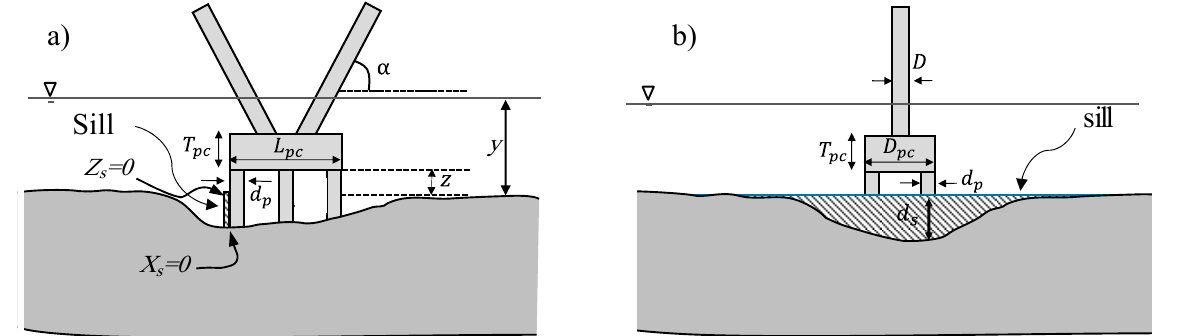
Figure 3. ( a ) Longitudinal and ( b ) transverse definition sketches of the investigated complex pier; sketches are for X s = 0 and Z s = 0.